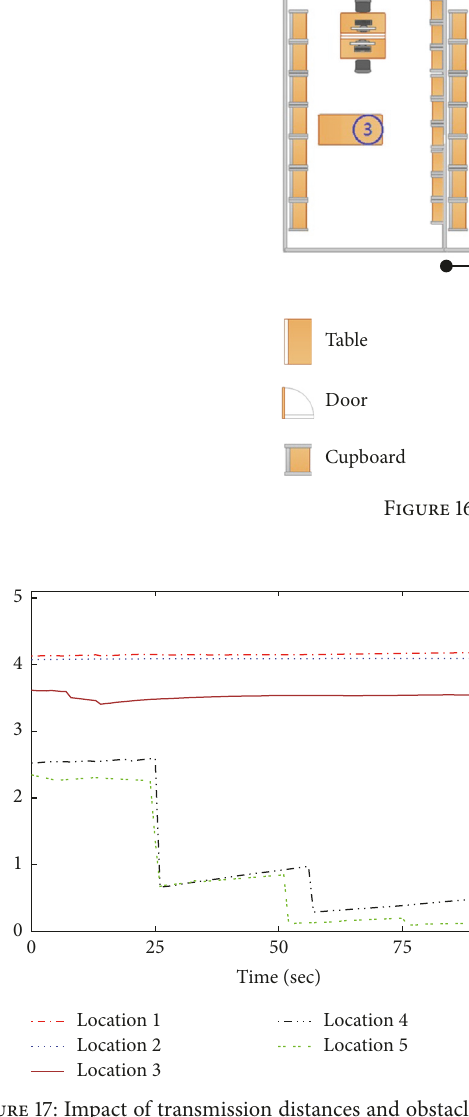
Figure 17: Impact of transmission distances and obstacles on QoE of wireless streaming